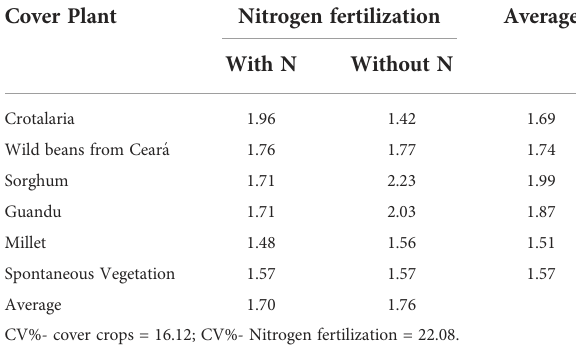
TABLE 4 Easily extractable glomalin (mg kg soil − 1 ) from cover crops, after corn cultivation, with and without nitrogen fertilization in cover, in